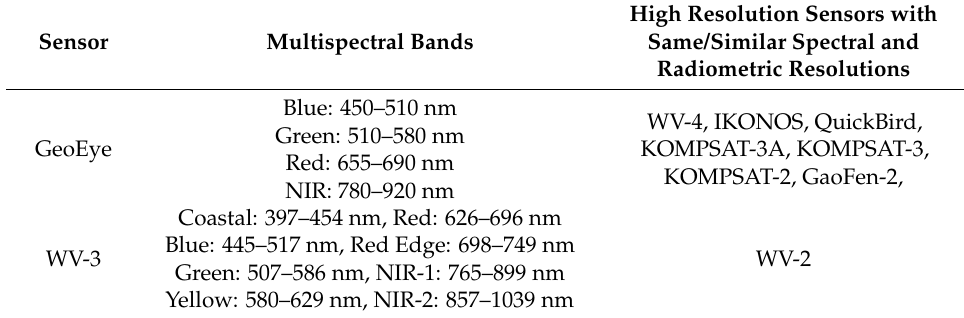
Table 1. Multispectral bands of GeoEye and WV-3 sensors and list of the sensors providing same/similar spectral resolutions.